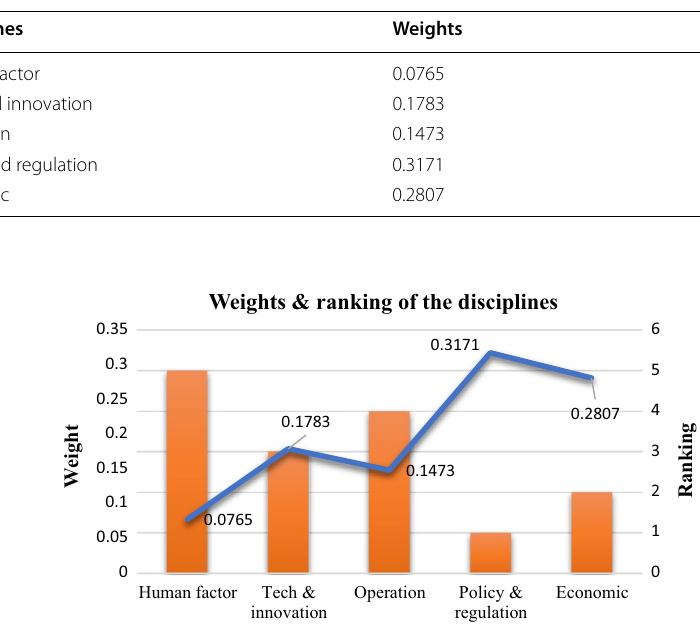
Table 14 Normalized defuzzified weights of disciplines